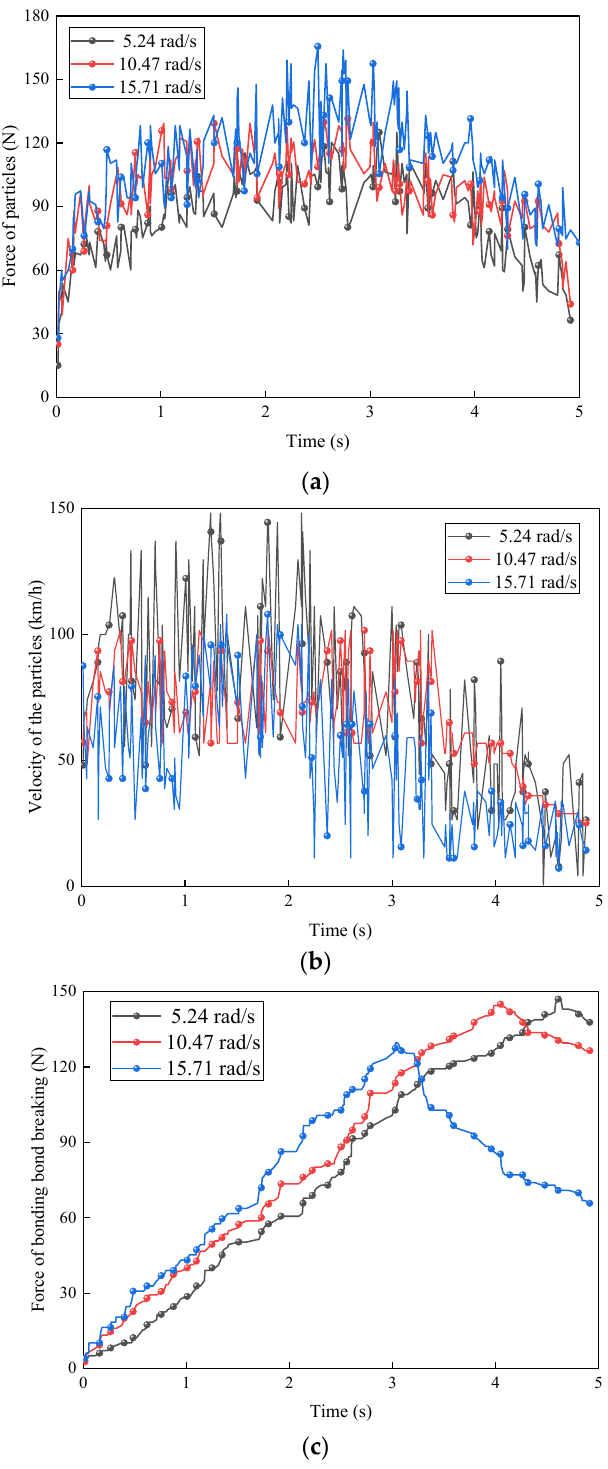
Figure 10. Variation of kinematic characteristics of particles with time in different concave plate speed. ( a ) Force curves of particles. ( b ) Velocity curves of particles. ( c ) Breaking force curves of the seed-stalk bonding bond.